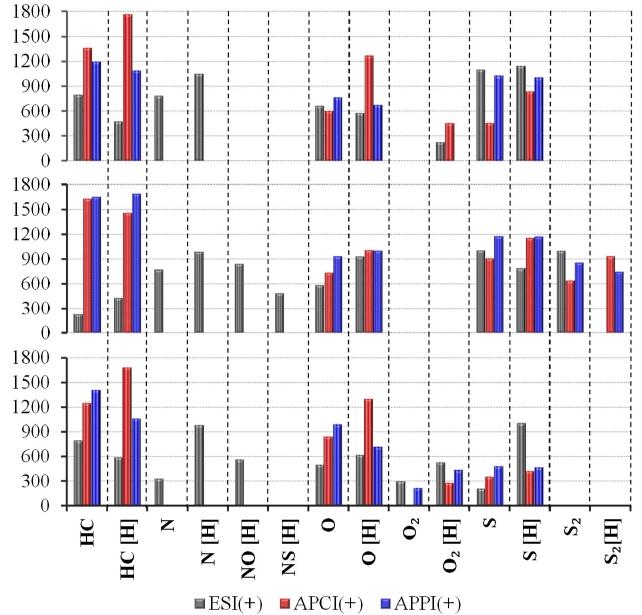
Figure 3. Population-based class distribution of the detected compound classes of heavy Eurasian oil ( top ), Arabic medium oil ( middle ) and E. Asian light oil ( bottom ), using different ionization techniques: Electrospray (ESI(+)) (grey), atmospheric pressure chemical ionization (APCI(+)) (red) and atmospheric pressure photoionization (APPI(+)) (blue). Energies 2019 , 12 , x FOR PEER REVIEW